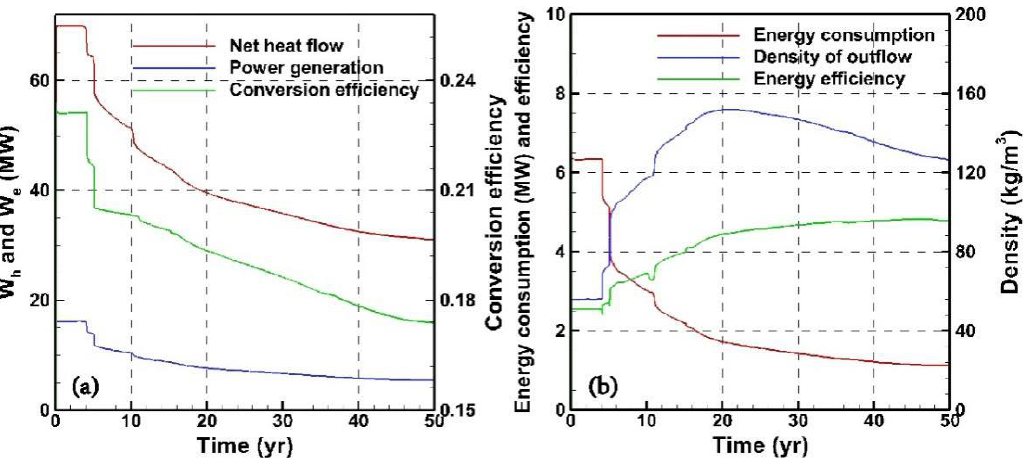
Figure 7. The evolution of net heat flow ( W h ), power generation ( W e ), and conversion efficiency ( f ) ( a ); and energy consumption, energy efficiency, and density of outflow ( b ).